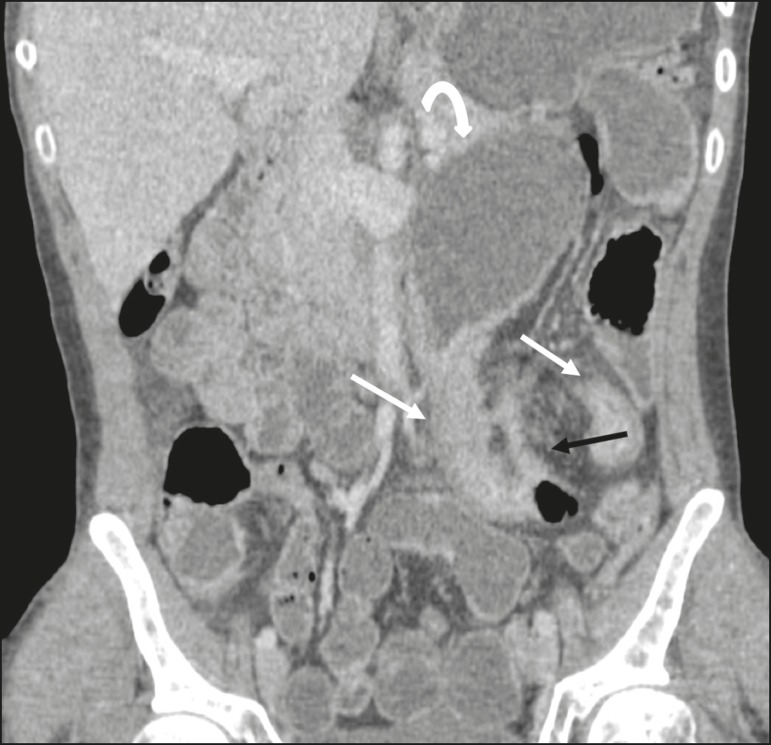
Coronal, contrast-enhanced CTE image showing stenotic, asymmetric wall thickening (straight white arrows) with prestenotic dilatation (curved white arrow). Note also the jejuno-jejunal fistulous tract, indicating penetrating disease, partially characterized in the image (black arrow).